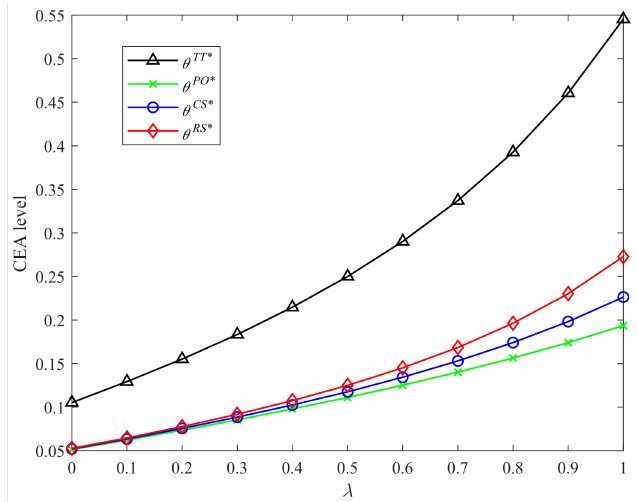
Figure 2. Comparison of CEA levels with different λ